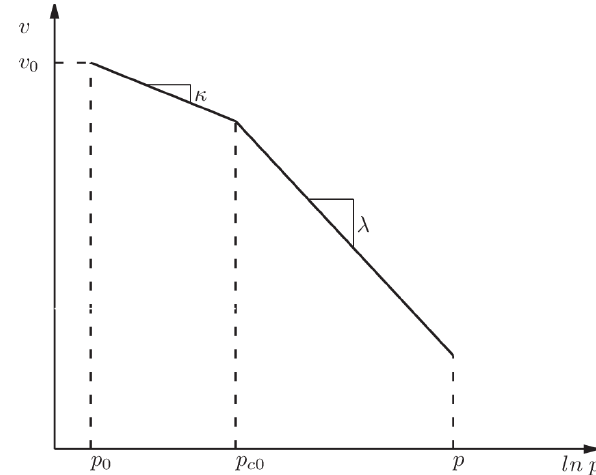
Figure 1: Schematic representation of the compressibility of a